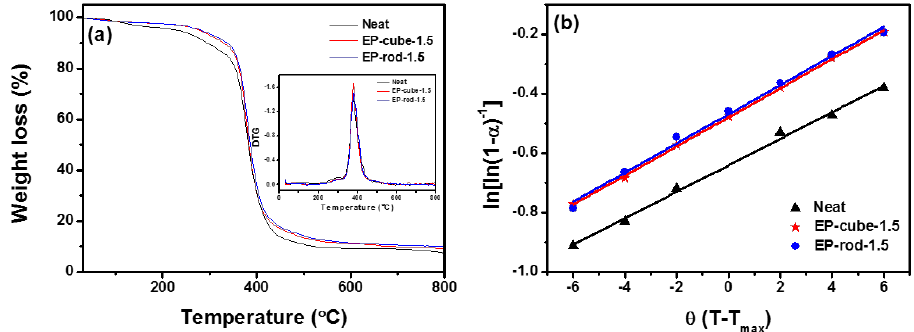
Figure 6. ( a ) TGA thermograms of the neat epoxy, EP-cube-1.5, and EP-rod-1.5 composites; and ( b ) plots of ln[ln(1 − α ) − 1 ] versus θ by using the Horowitz–Metzger